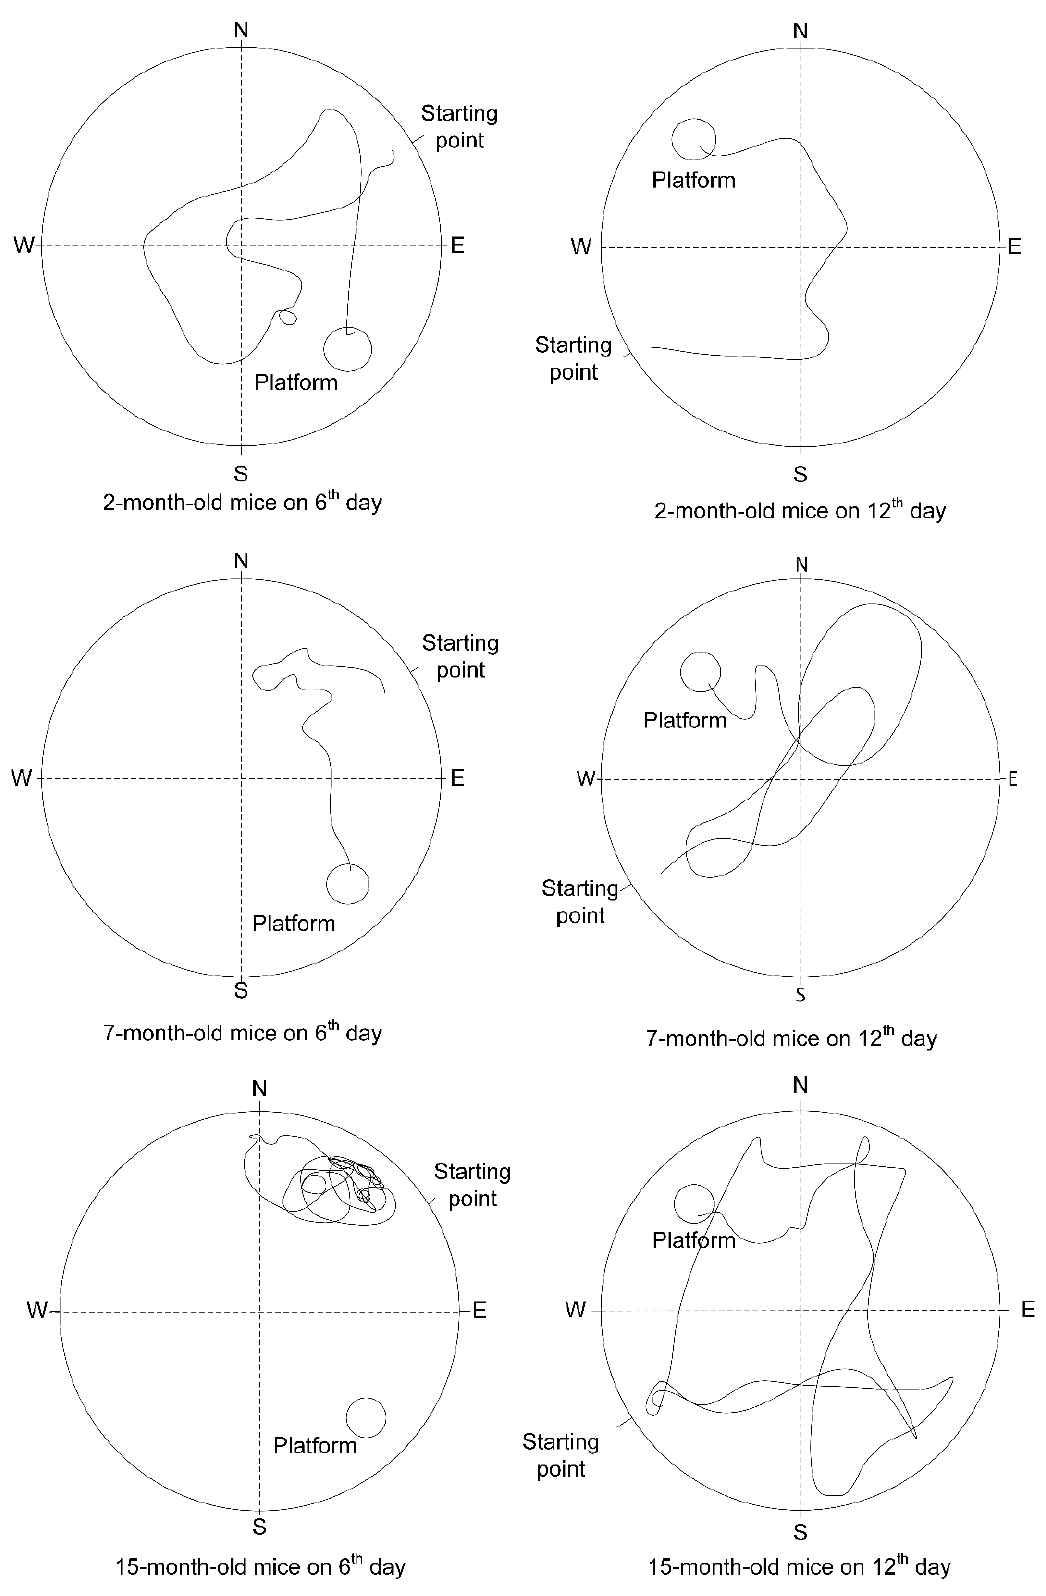
Figure 7. The results of the Morris water maze for reference memory. The most representative pathways for mice from 3 groups are shown on the sixth trial day ( left column) and the twelfth trial day ( right column).